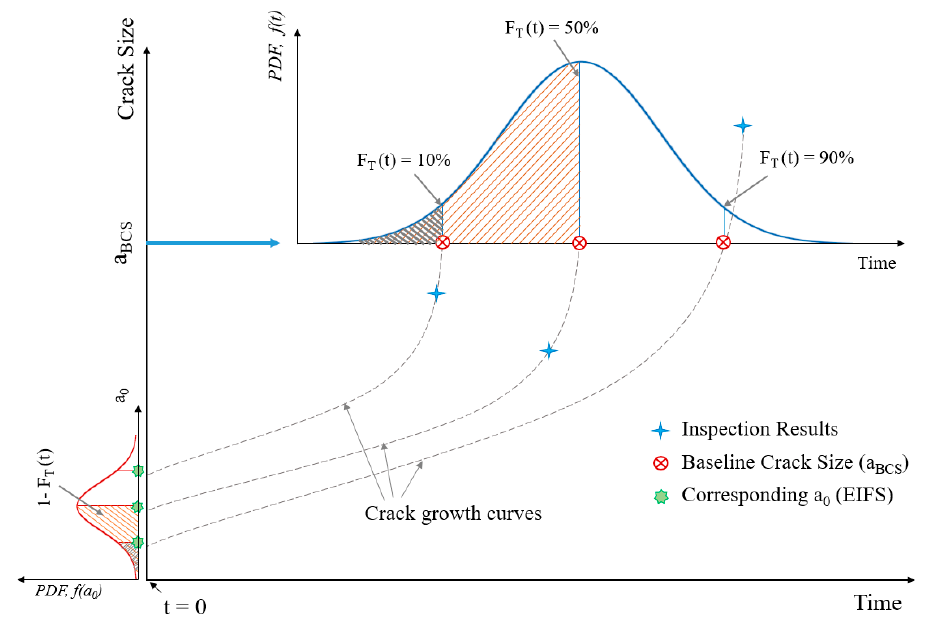
Figure 4. Obtaining the equivalent initial flaw size (EIFS) distribution